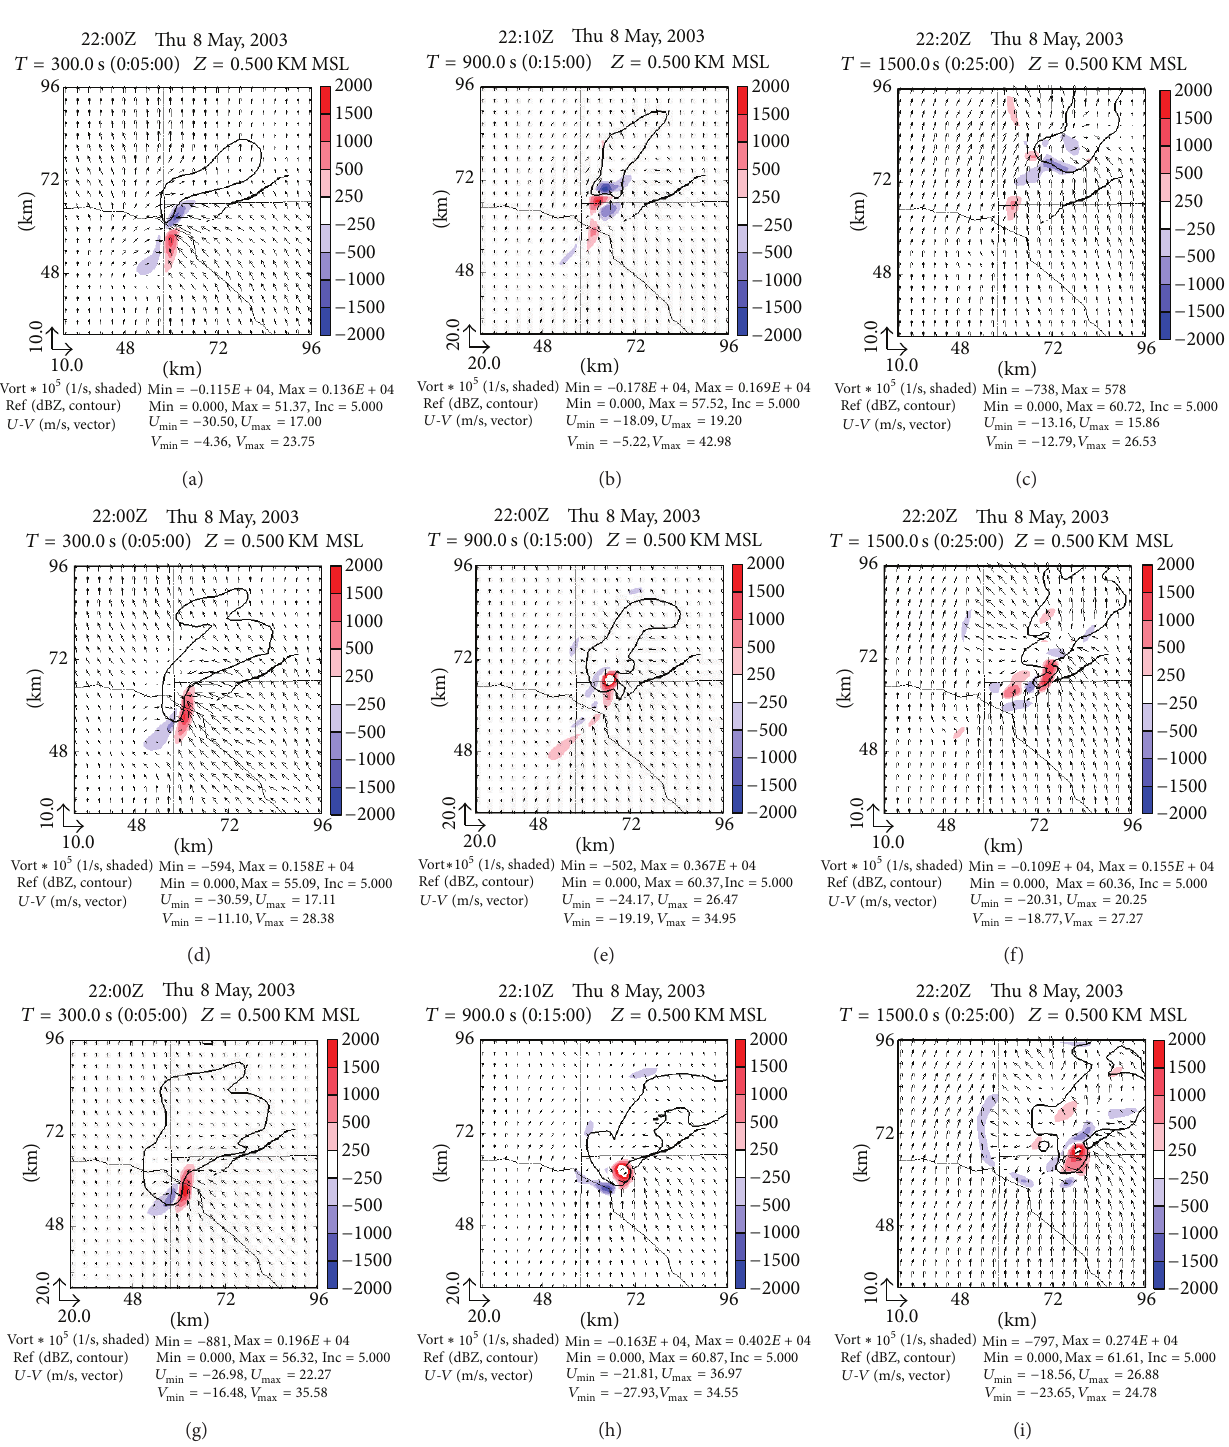
Figure 12: 0.5 km vertical vorticity (10 −5 s −1 ) and horizontal wind vectors for the 1RAD forecast ((a)–(c)), 2RAD forecast ((d)–(f)), and control forecast ((g)–(i)) initialized at 2155 UTC and shown at 10-minute intervals starting at 2200 UTC until 2220UTC. Vorticity values greater than 2 × 10 −2 s −1 are shown as transparent. The thicker black line denotes the location of the observed damage path of the